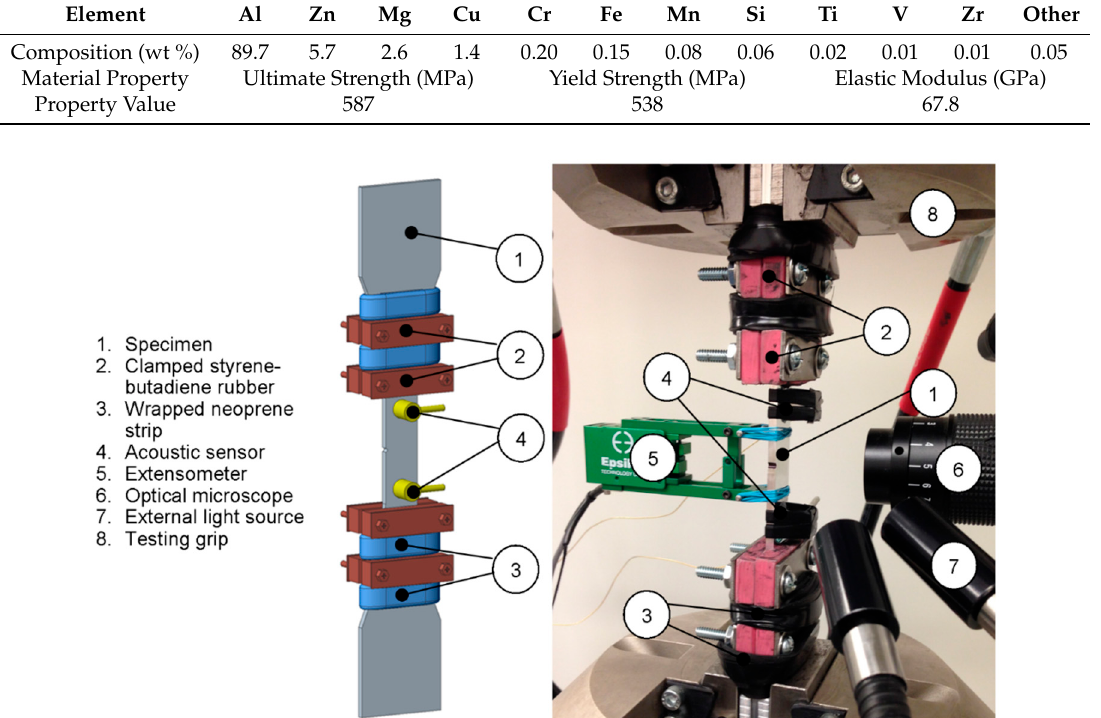
Figure 4. Experimental setup showing the specimen, AE sensors, mechanical damping apparatus and crack growth monitoring system.